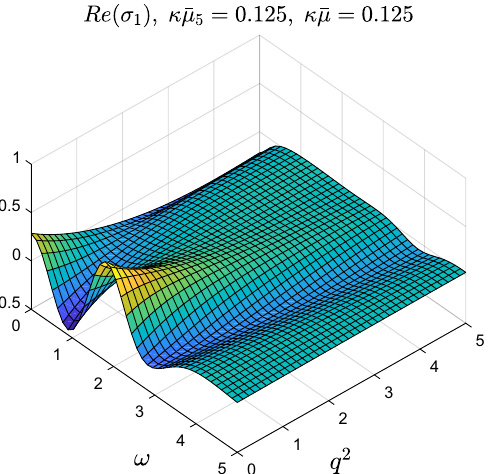
Fig. 13 TCF σ 1 as a function of ω and q 2 when κ ¯ μ = κ ¯ μ 5 = 1 / 8